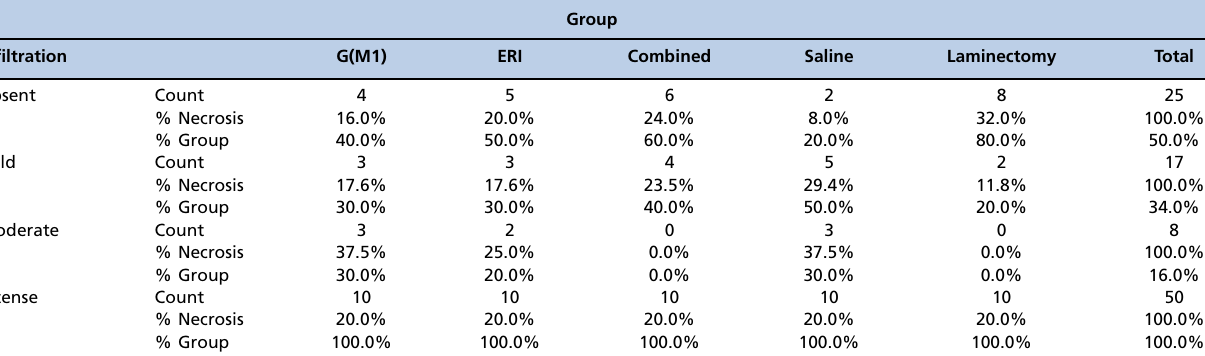
Table 7 - Cellular infiltration into the distal section of the spinal cord in Wistar rats subjected to experimental spinal cord contusion